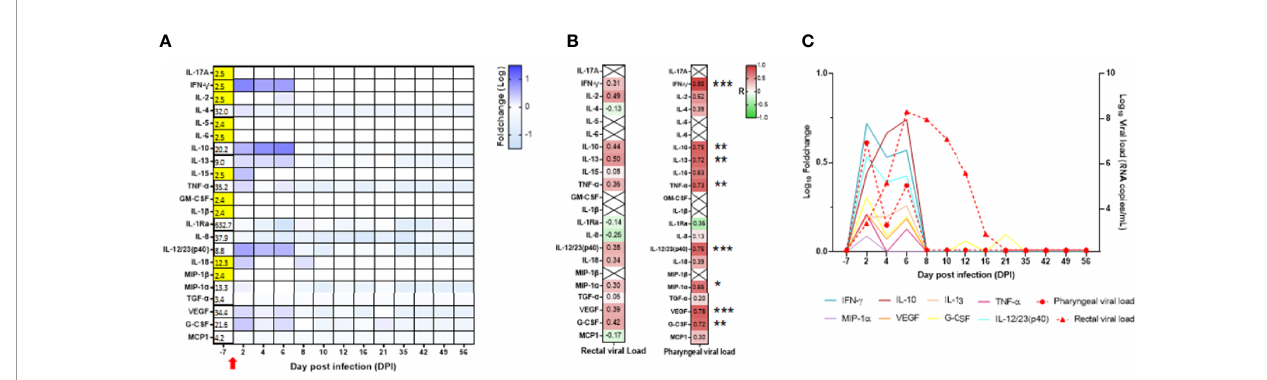
FIGURE 9 | Cytokine analyses in the neonate rectal compartment. (A) Heatmap representing the evolution of cytokines over time (in the log of fold-change from the baseline). Variations are shown on a blue scale. Basal concentrations are shown on the left side of the heatmap. Highlighted yellow values correspond to the detection threshold. (B) Spearman correlation analysis between SARS-CoV-2 viral RNA load in the rectal (left) or oropharyngeal (right) compartment and the kinetics of cytokines in the rectal compartment. Correlation factors determined on the whole kinetics are shown on the heatmap with a red to green scale.